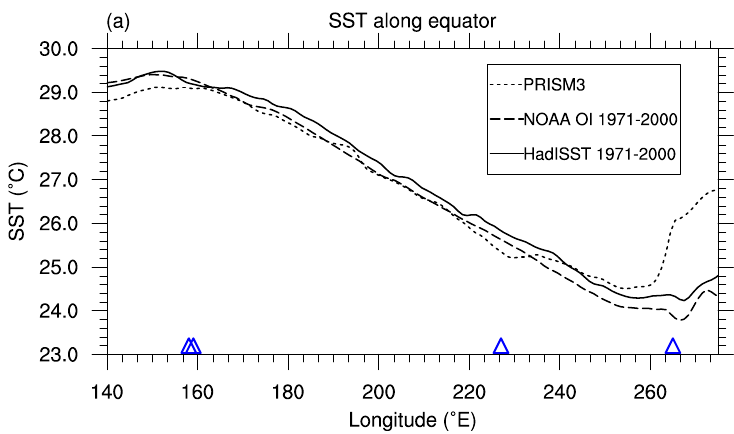
Fig. 8. Zonal SST profile at the equator from observations in different datasets: the HadISST (solid line) and the NOAA Optimum Interpola- tion SST V2, 1971–2000 timeseries (dashed line) for the present-day conditions. The dotted line denotes the zonal SST profile at the equator as inferred from proxy data for the Pliocene in the PRISM3D dataset. The triangles along the x-axis indicate the zonal position of data points along the equator, where the PRISM data are based